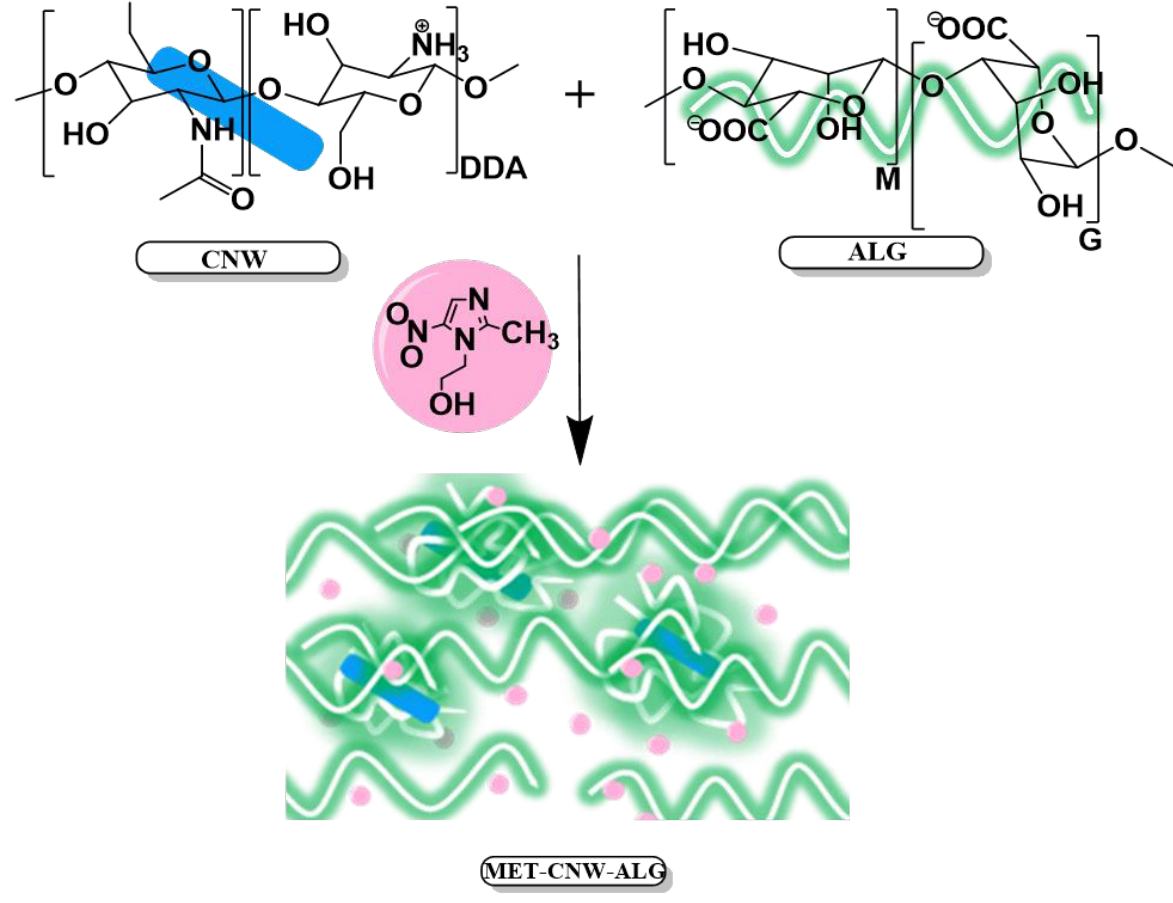
Table 1. Preparation conditions and composition of CNW – ALG PECs.